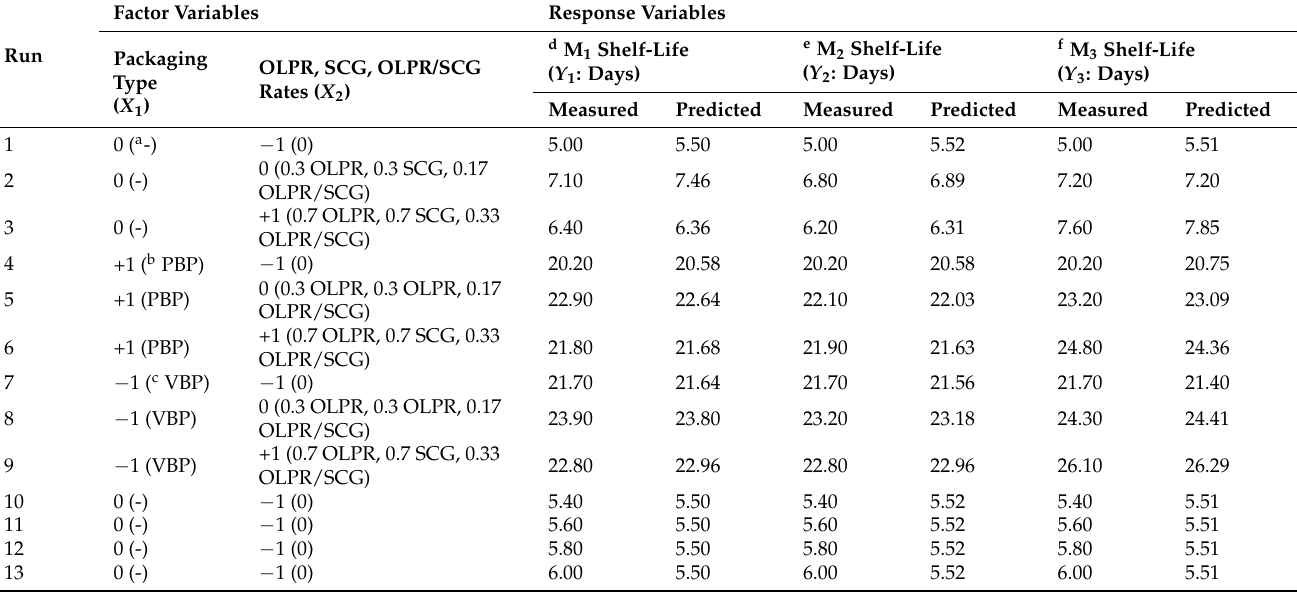
Table 5. Measured and predicted response matrix for the shelf life of mushrooms (days) stored at 4 ◦